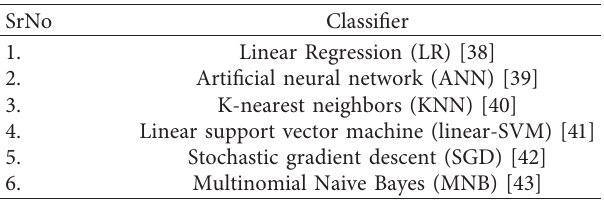
Table 5: Classification algorithms used for comparison for citation intent